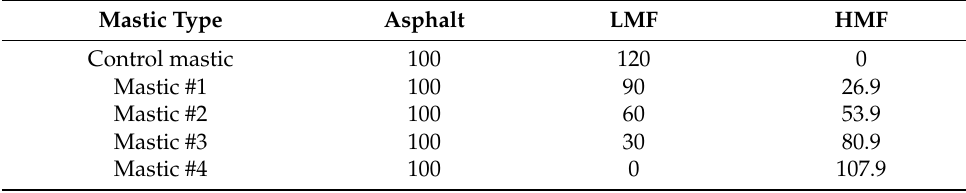
Table 2. Mass ratios of components in asphalt mastic (% by weight).